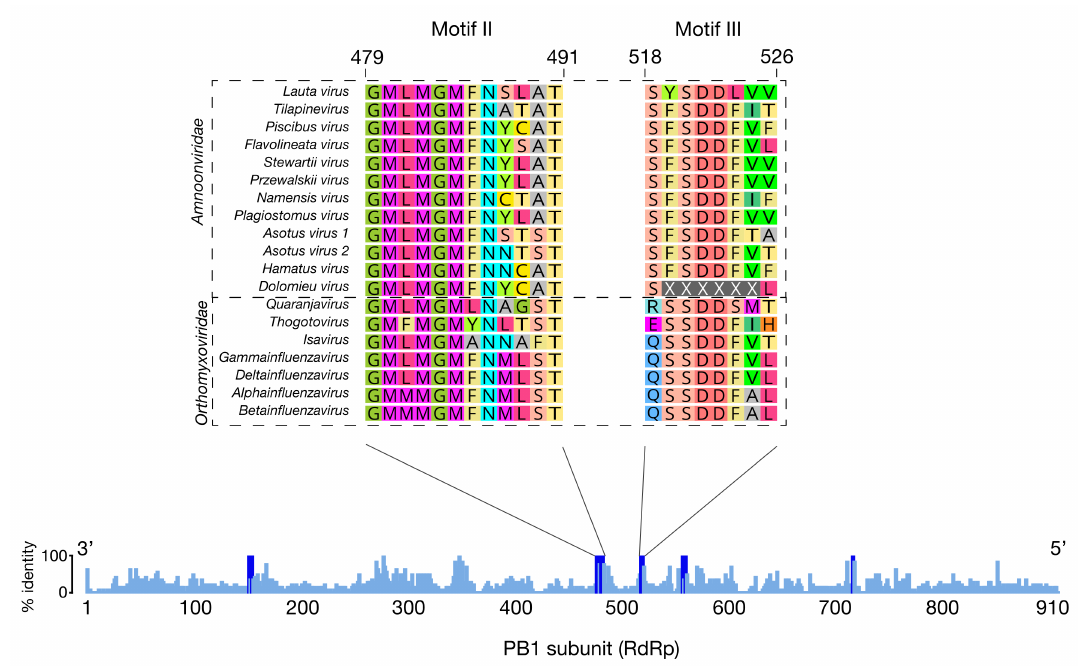
Figure 1. Alignment of viruses within the order Articulavirales in the RdRp subunit PB1. Blue bars illustrate the mean pairwise identity over all the pairs in each column where royal blue highlights conserved motifs with 100% identity. The sequences of two motifs (II and III) are shown where all sequences